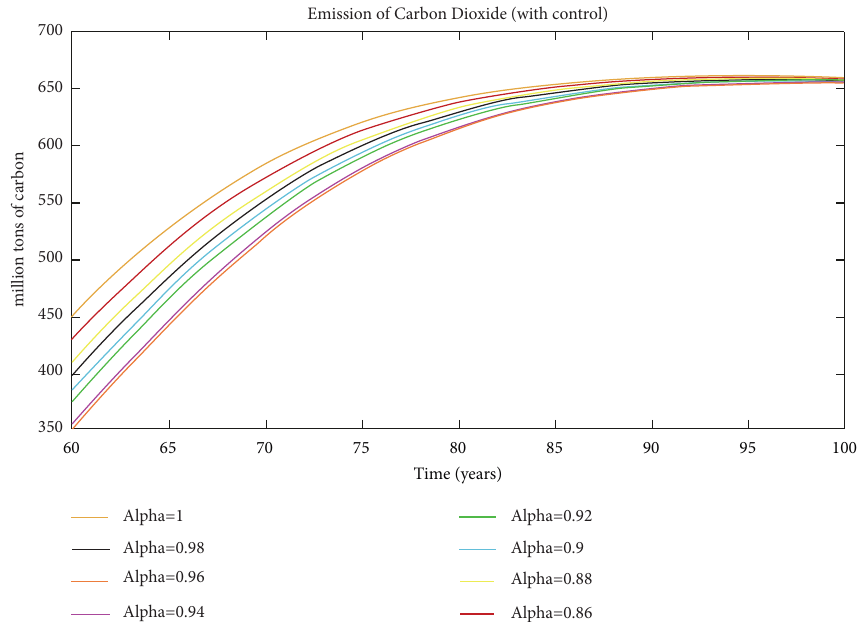
Figure 10: Comparison of the amount of CO